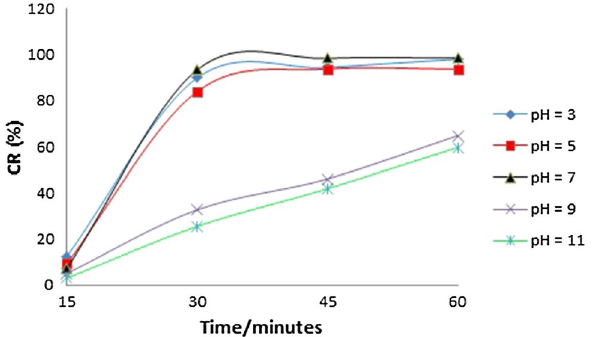
Fig. 7 Effect of the initial concentration of NaCl on the removal effi- ciency of Eriochrome Black 0.20 g L −1 . electrolysis time = 120 min; pH 7.0; and E = 7.0